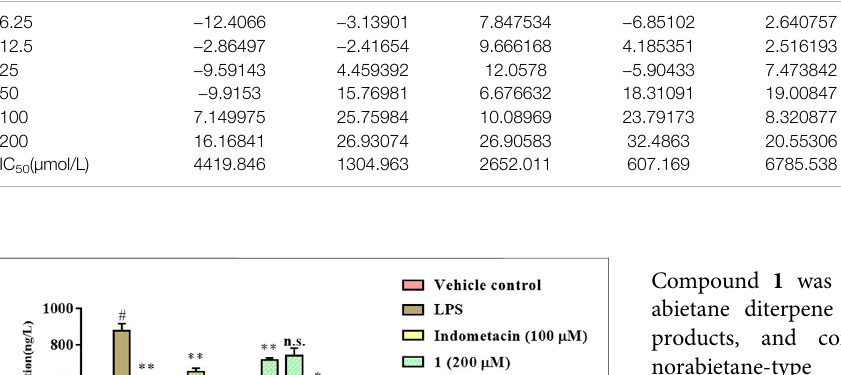
TABLE 3 | RAW 264.7 macrophage viability test of the isolated compounds. Concentration (µM)